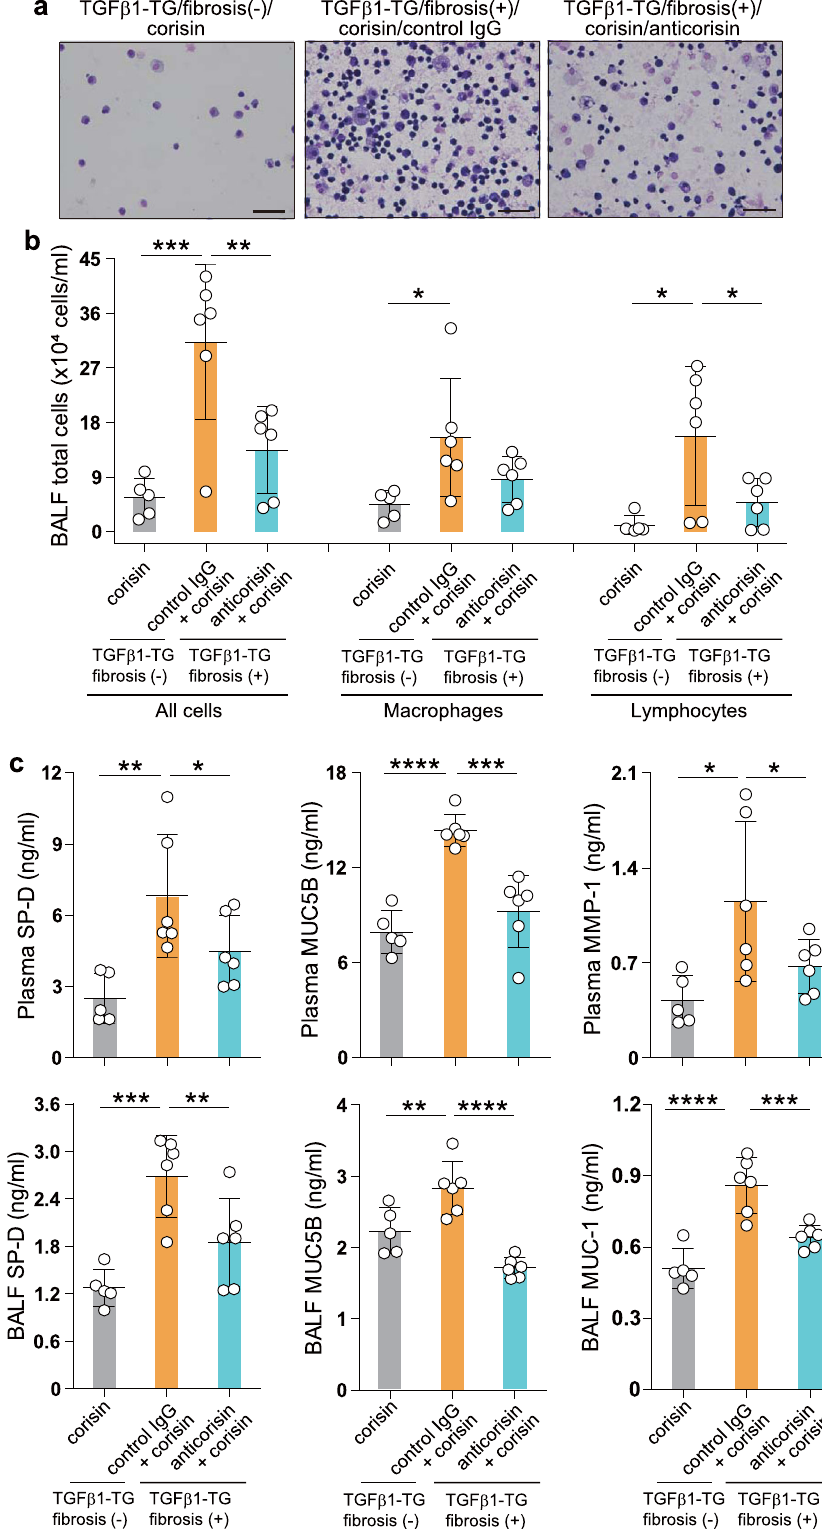
Mice receiving saline through osmotic mini-pumps and treated with corisin or scrambled peptide showed no signi fi cant changes. These fi ndings showed that corisin can also exacerbate the disease in BLM- induced lung fi